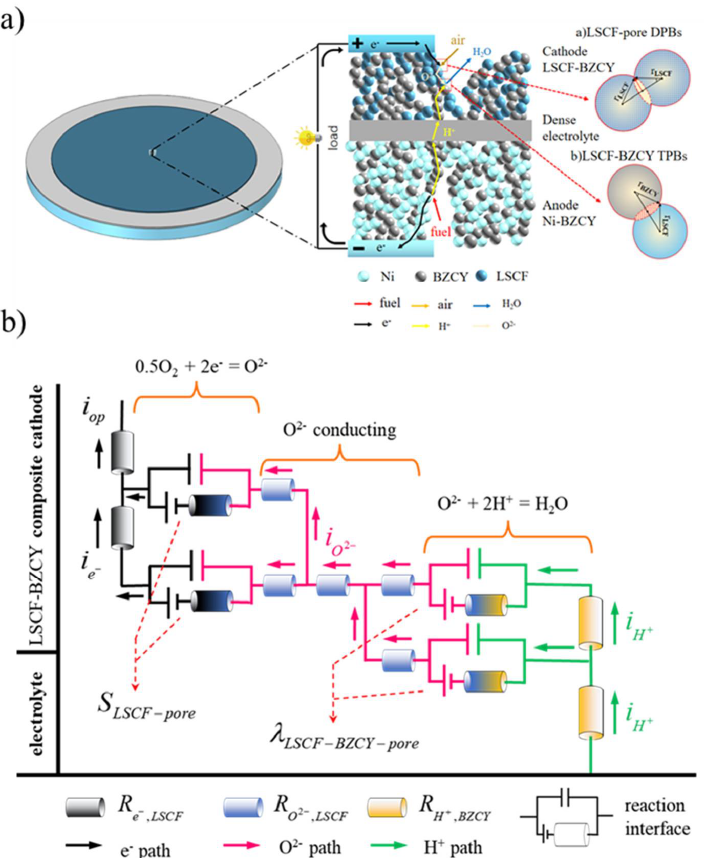
Figure 1. ( a ) Illustration of the electrochemical and physical coupling processes within a typical Ni-BZCY/BZCY/BZCY-LSCF PCFC button cell; ( b ) the corresponding equivalent circuit of e − , O 2− , and H + electric processes within the LSCF-BZCY composite cathode.